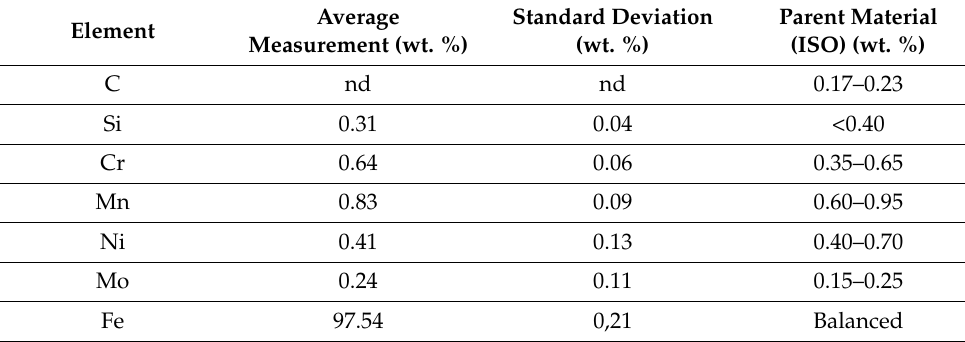
Table 2. The chemical composition of GA 21NiCrMo2 steel powder.